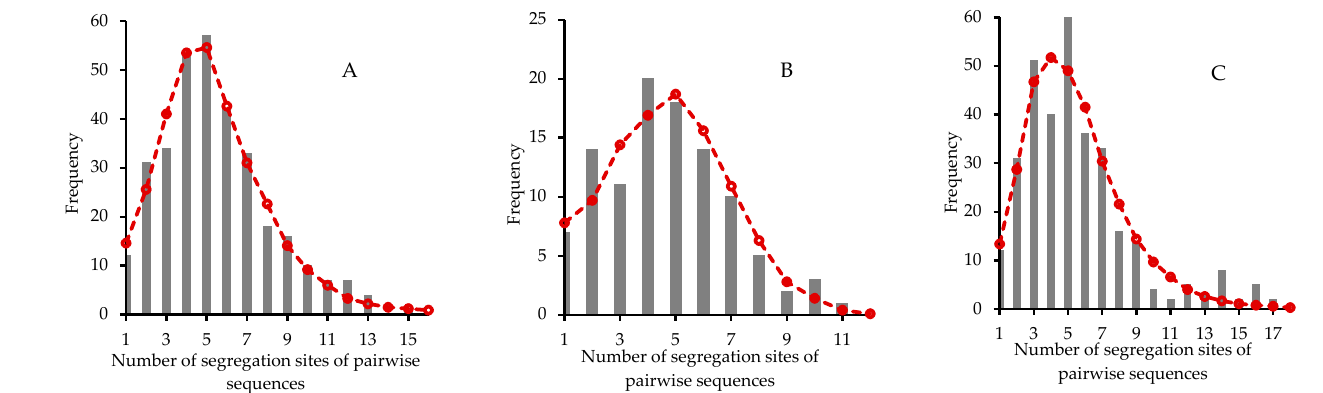
Figure 6. Analysis of mismatch distribution using haploid nrDNA ITS sequences. ( A ) population XL, ( B ) population LD, and ( C ) population WM. The bar lines are the observed frequencies under different numbers of segregation sites of pairwise sequences, whereas the red dashed lines represent the expected frequencies under a model of sudden population expansion [53].